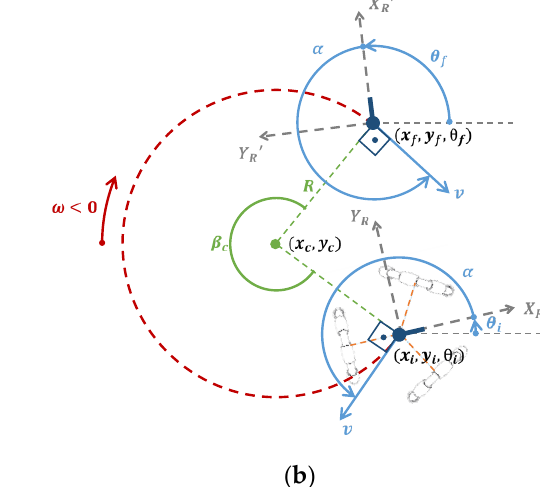
Figure 5. Representation of the trajectory of the mobile robot: ( a ) case with translation and rotation in the counterclockwise direction (𝜔 > 0) and ( b ) case with translation and rotation in the clockwise direction (𝜔 < 0) .